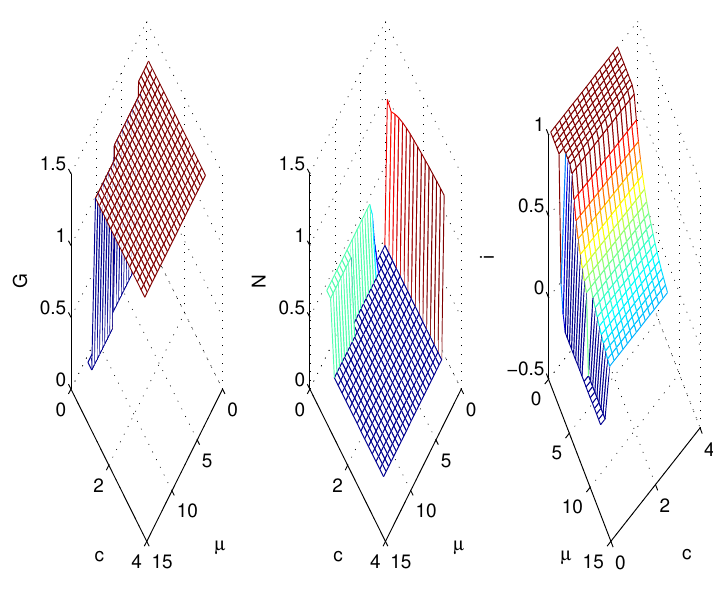
Figure 3. The ecosystem behavior as a function of c and µ ; in a very narrow stripe for moderate values of the mortality and small values of c , meaning that the native squirrels can better compete with the invaders, the red squirrels could thrive, with the disease being eradicated, as well as the invaders vanishing.